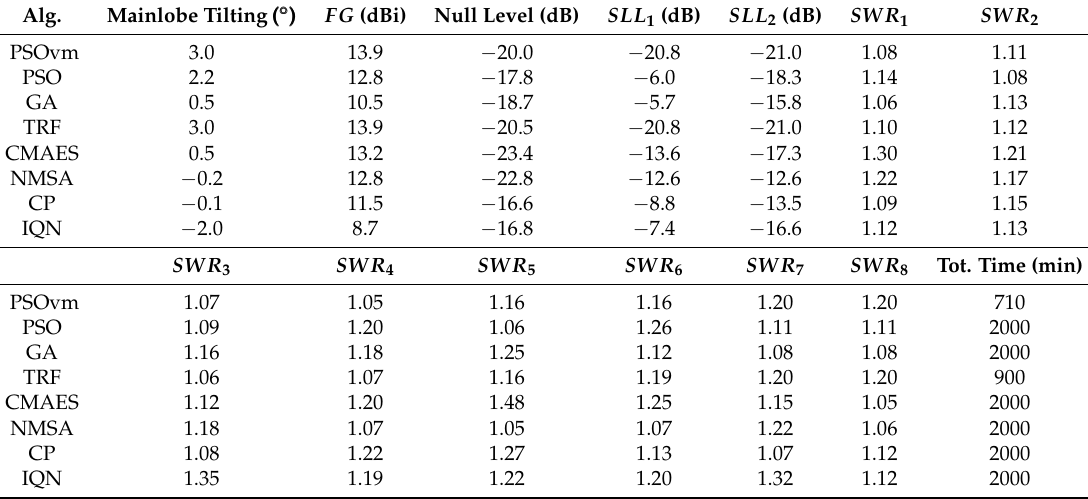
Table 6. Comparison of Optimization